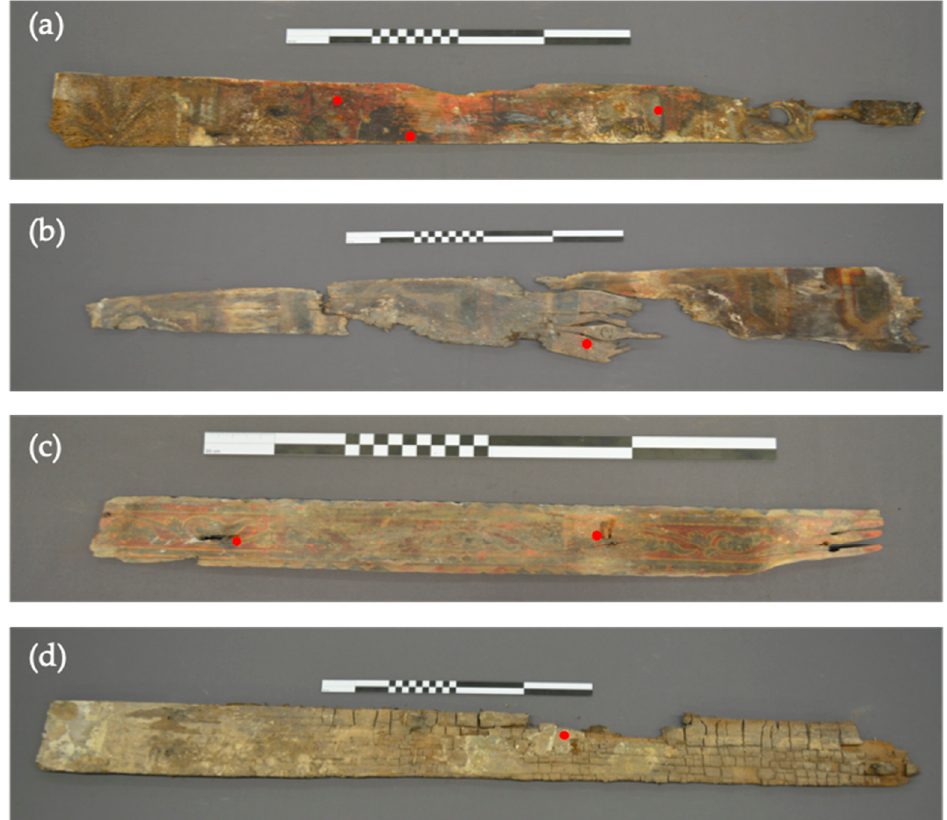
Figure 16. Polychromed wooden panels. ( a ) panel C, ( b ) panel D, ( c ) panel F, and ( d ) panel K, where the samples are taken.